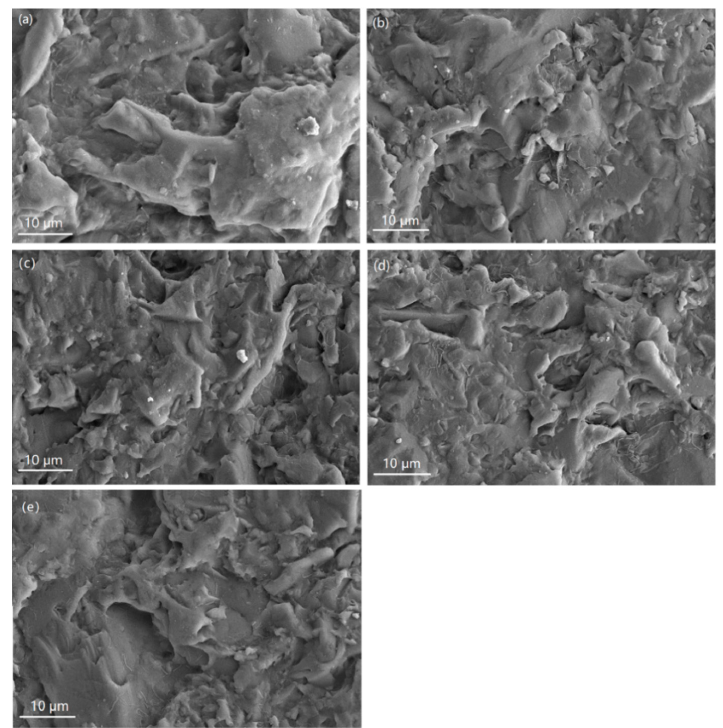
Figure 1. SEM micrographs of the specimens after pre-treatment. ( a ) Specimen 1; ( b ) Specimen 2; ( c ) Specimen 3; ( d ) Specimen 4; ( e ) Specimen 5.